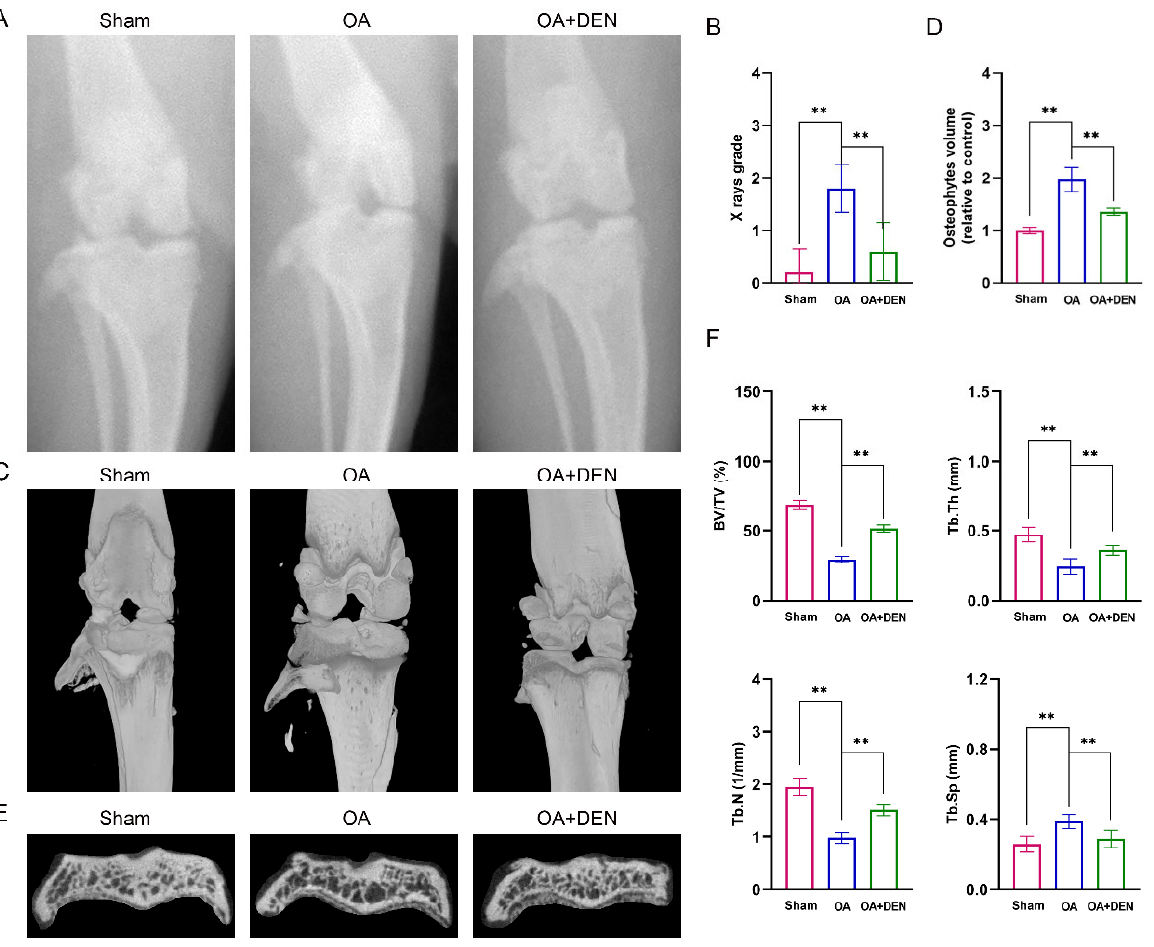
Figure 7. Imaging evaluation of dendrobine (DEN) on the progression of osteoarthritis (OA) in a rat model of OA. ( A , B ) X-ray images of rat knee and X-ray grade, n = 5. ( C , D ) Micro-CT images of rat knee and osteophytes volume, n = 5. ( E , F ) Micro-CT images of subchondral bone and relevant parameters, including total bone volume/total tissue volume (BV/TV), trabecular number (Tb.N), thickness (Tb.Th), and separation (Tb.Sp), n = 5. The values presented are the means ± SD. ** p <